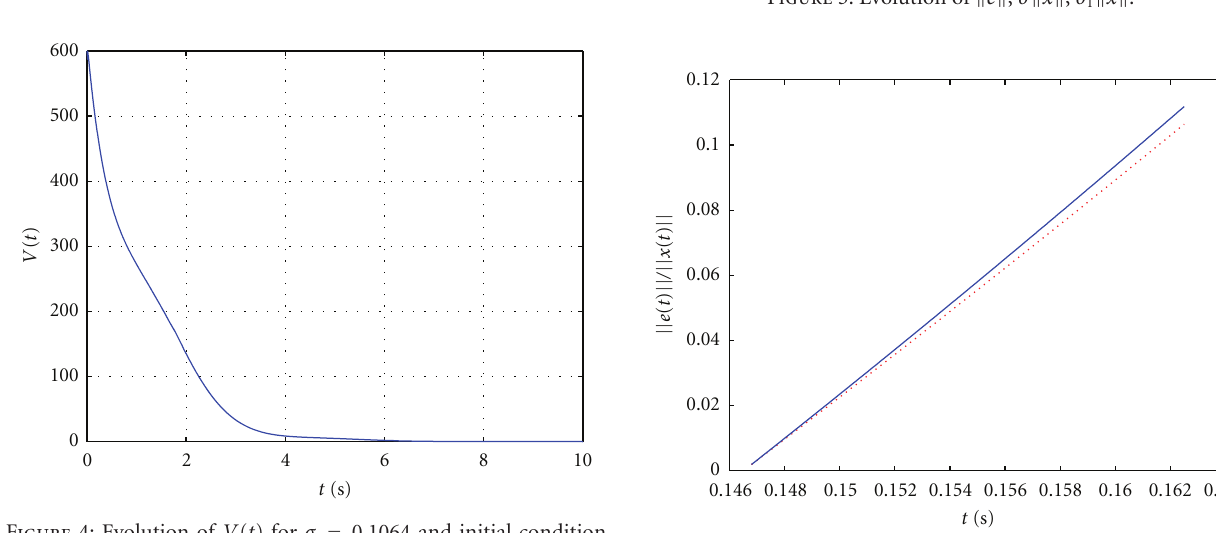
Figure 5: Evolution of (cid:3) e (cid:3) , σ (cid:3) x (cid:3) , σ 1 (cid:3) x (cid:3) .